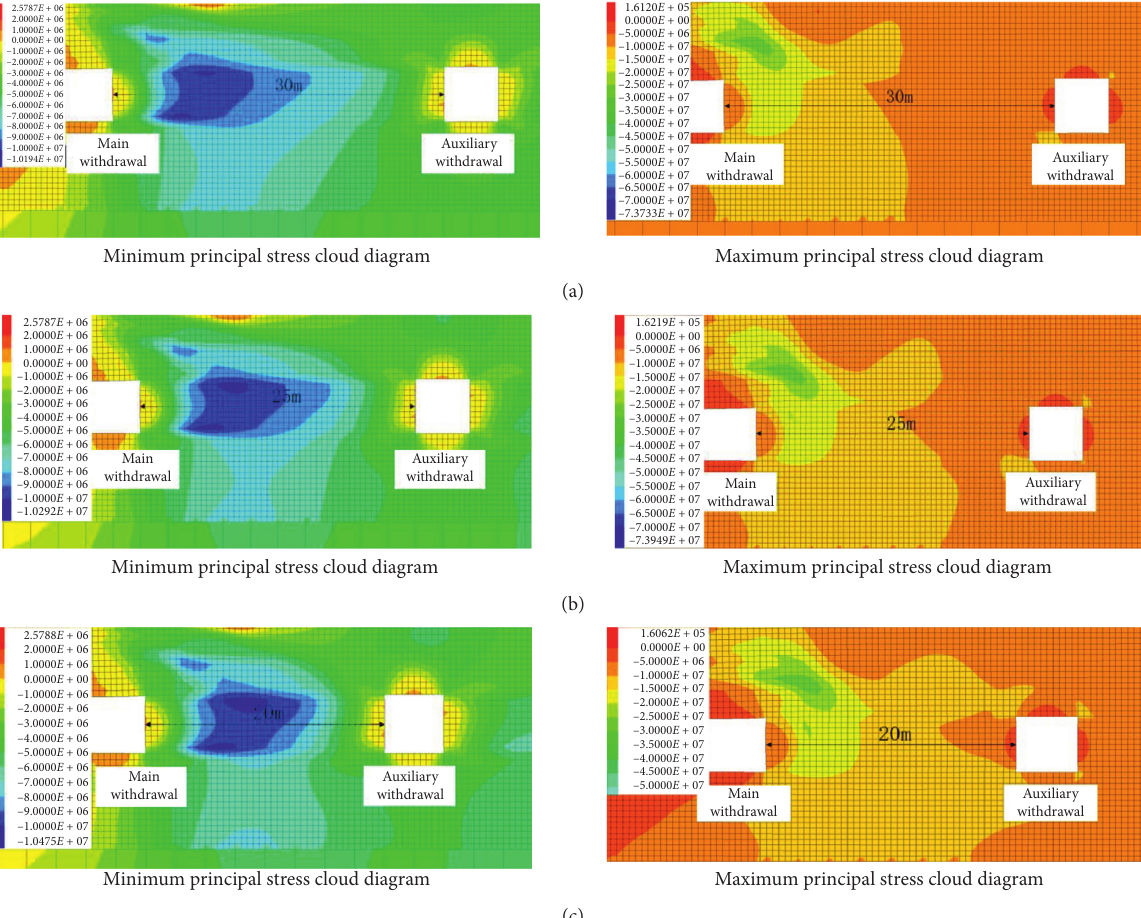
Figure 19: Maximum and minimum principal stress cloud diagrams when Panel 31113 is penetrated. (a) Main and auxiliary withdrawal spacing � 30m. (b) Main and auxiliary withdrawal spacing � 25m. (c) Main and auxiliary withdrawal spacing � 20